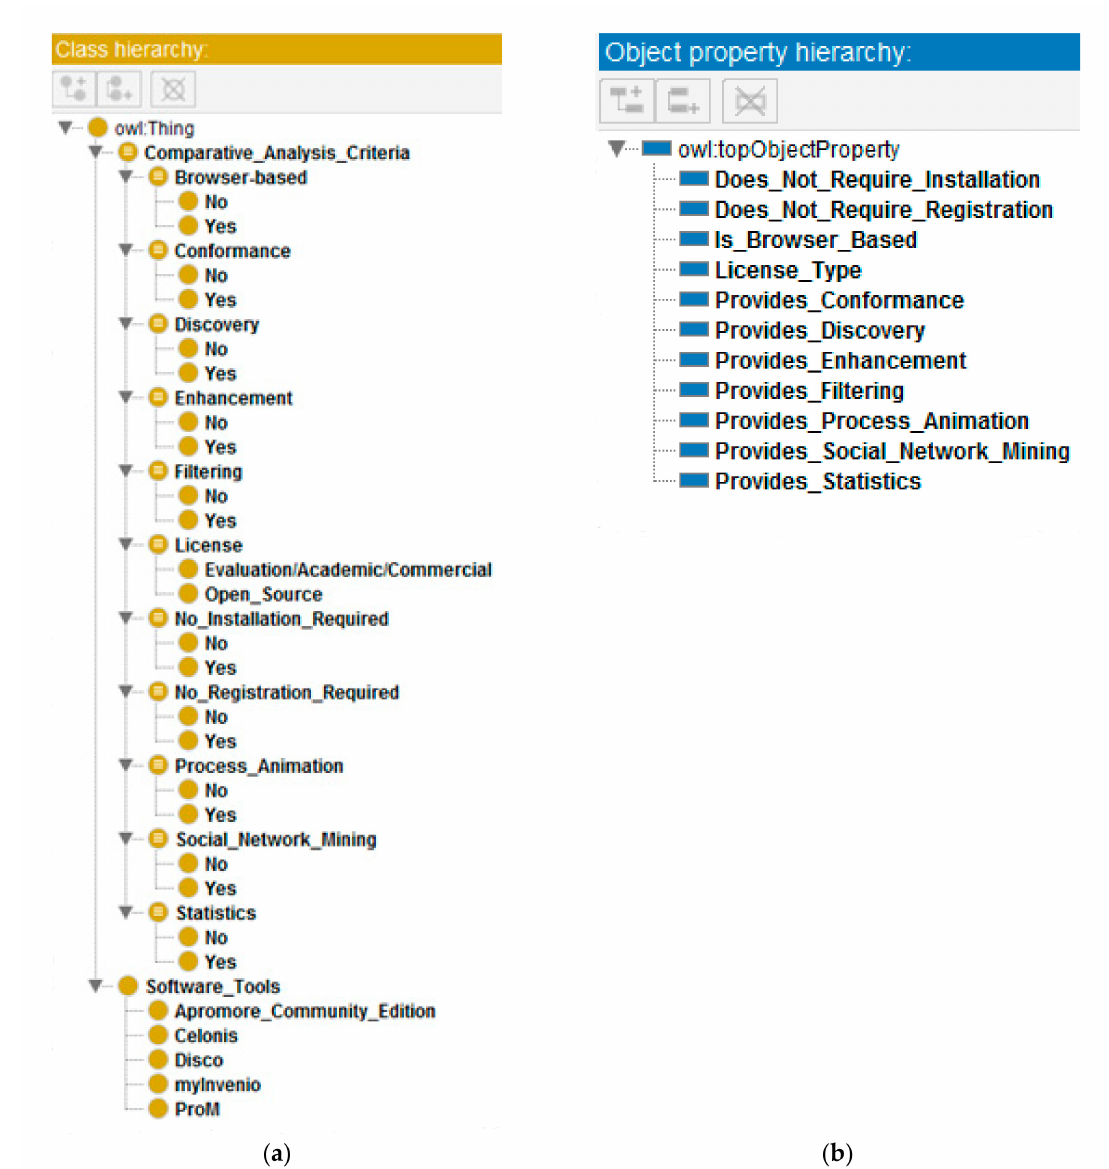
Figure 4. ( a ) Class hierarchy (Prot é g é 5.5.0); ( b ) object property hierarchy (Prot é g é